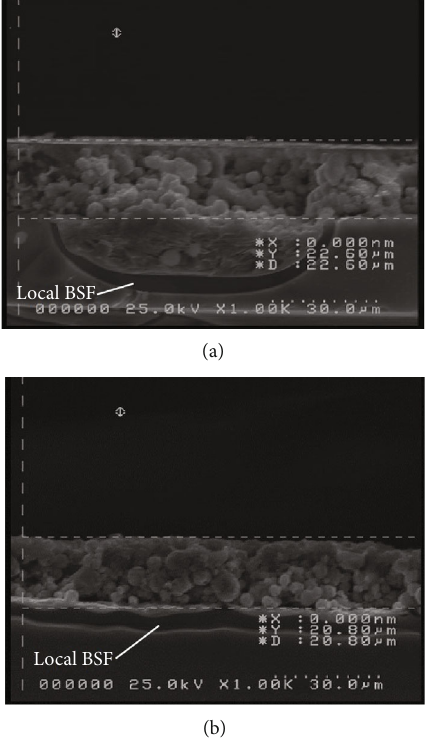
Figure 10: Local BSF for a PERC cell (a) and a full BSF for an Al- BSF cell (b).